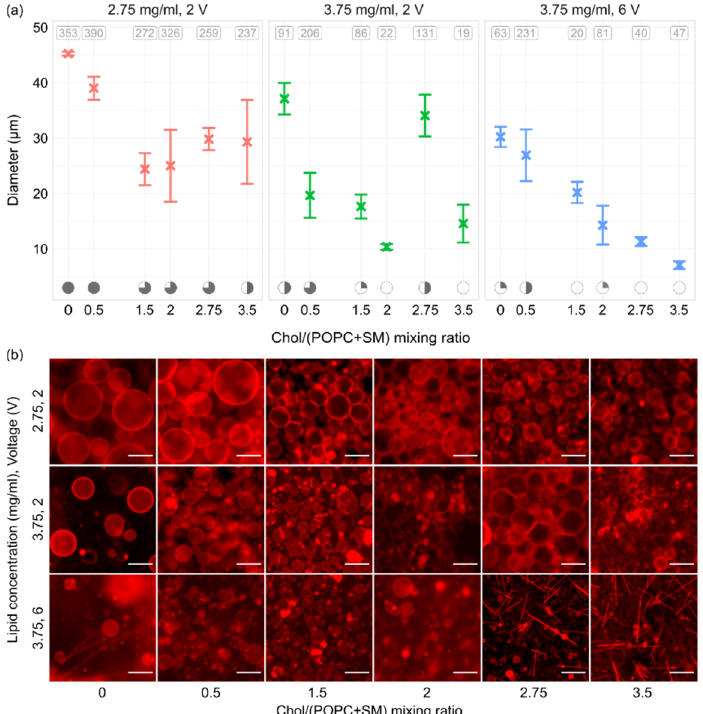
Figure 6. ( a ) GUVs sizes for different Chol concentrations, lipid concentrations (lipid film thicknesses), and voltages. All experiments were performed using a 1/1/1 POPC/SM/Chol mixture and a frequency of 10 Hz. At the top of the panels, the average number of tracked vesicles per sample is displayed. Electroformation successfulness is displayed at the bottom of the panels. Successfulness takes into account the yield and size of GUVs and the amount of defects. It is displayed here through circle fullness, where a fuller circle indicates better successfulness. Empty circles denote that no GUVs were formed or electroformation efficiency was very low. ( b ) Representative fluorescence microscopy images for conditions displayed in the panels above. The scale bar in the bottom right of the images denotes 50 µ